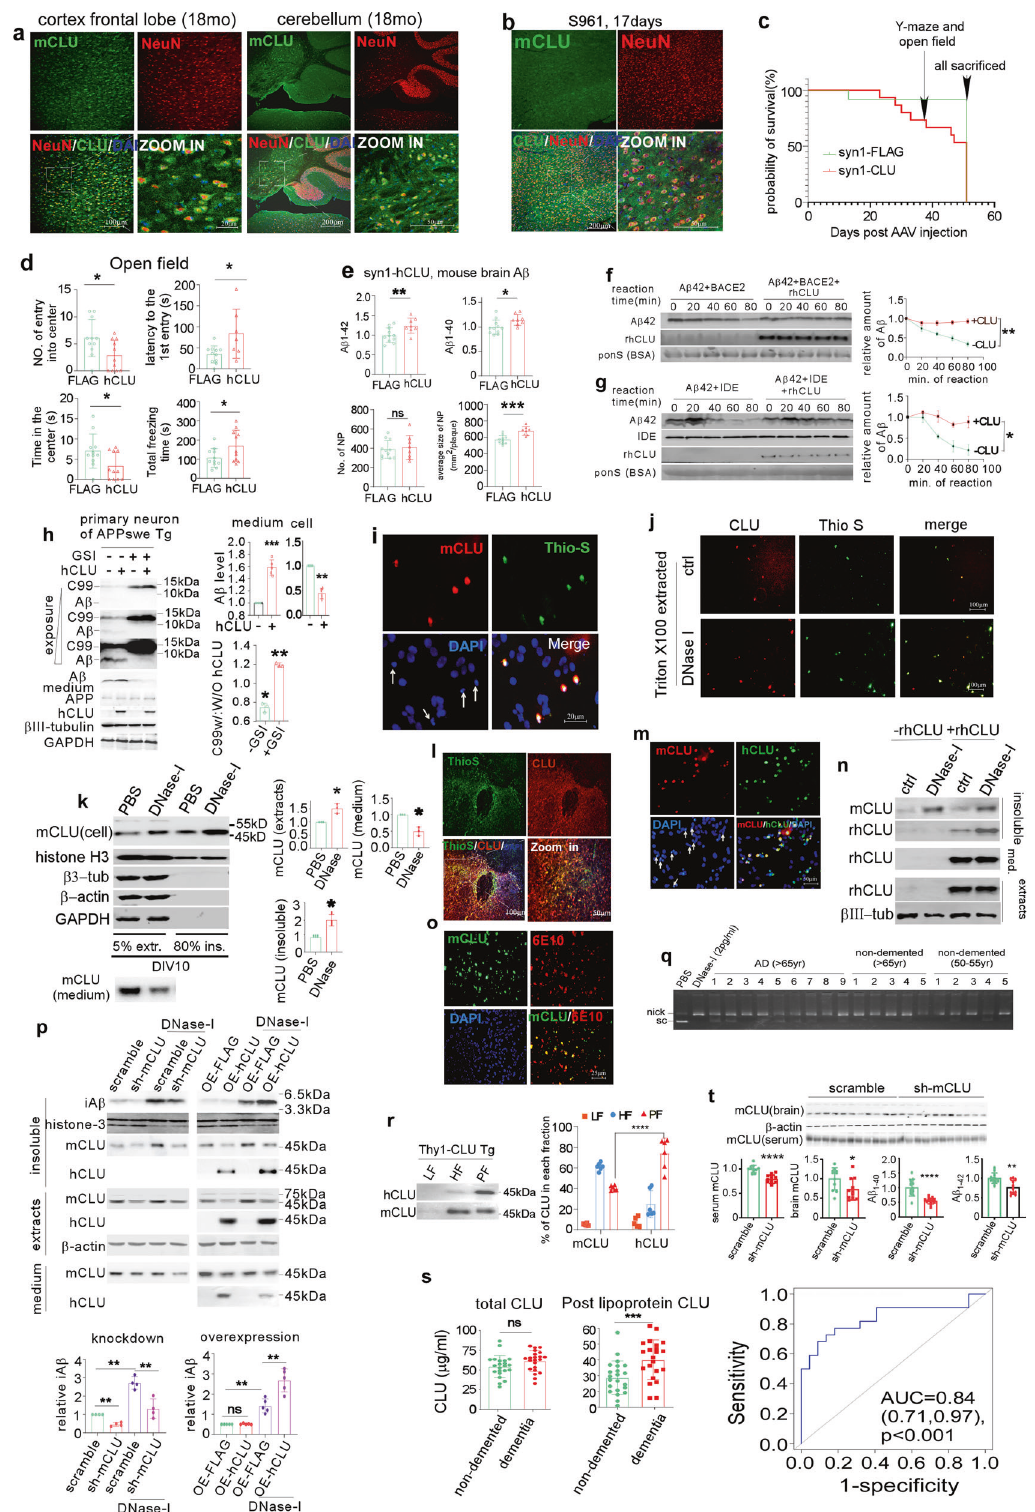
through CLU to generate NP, and A β level may be unessential (Supplementary Fig. S6). CLU in the serum, CSF, and the conditioned medium of PN shows different pattern in heparin-manganese fractionation to isolate lipoproteins (Supplementary Fig. S7a, b). In a transgenic